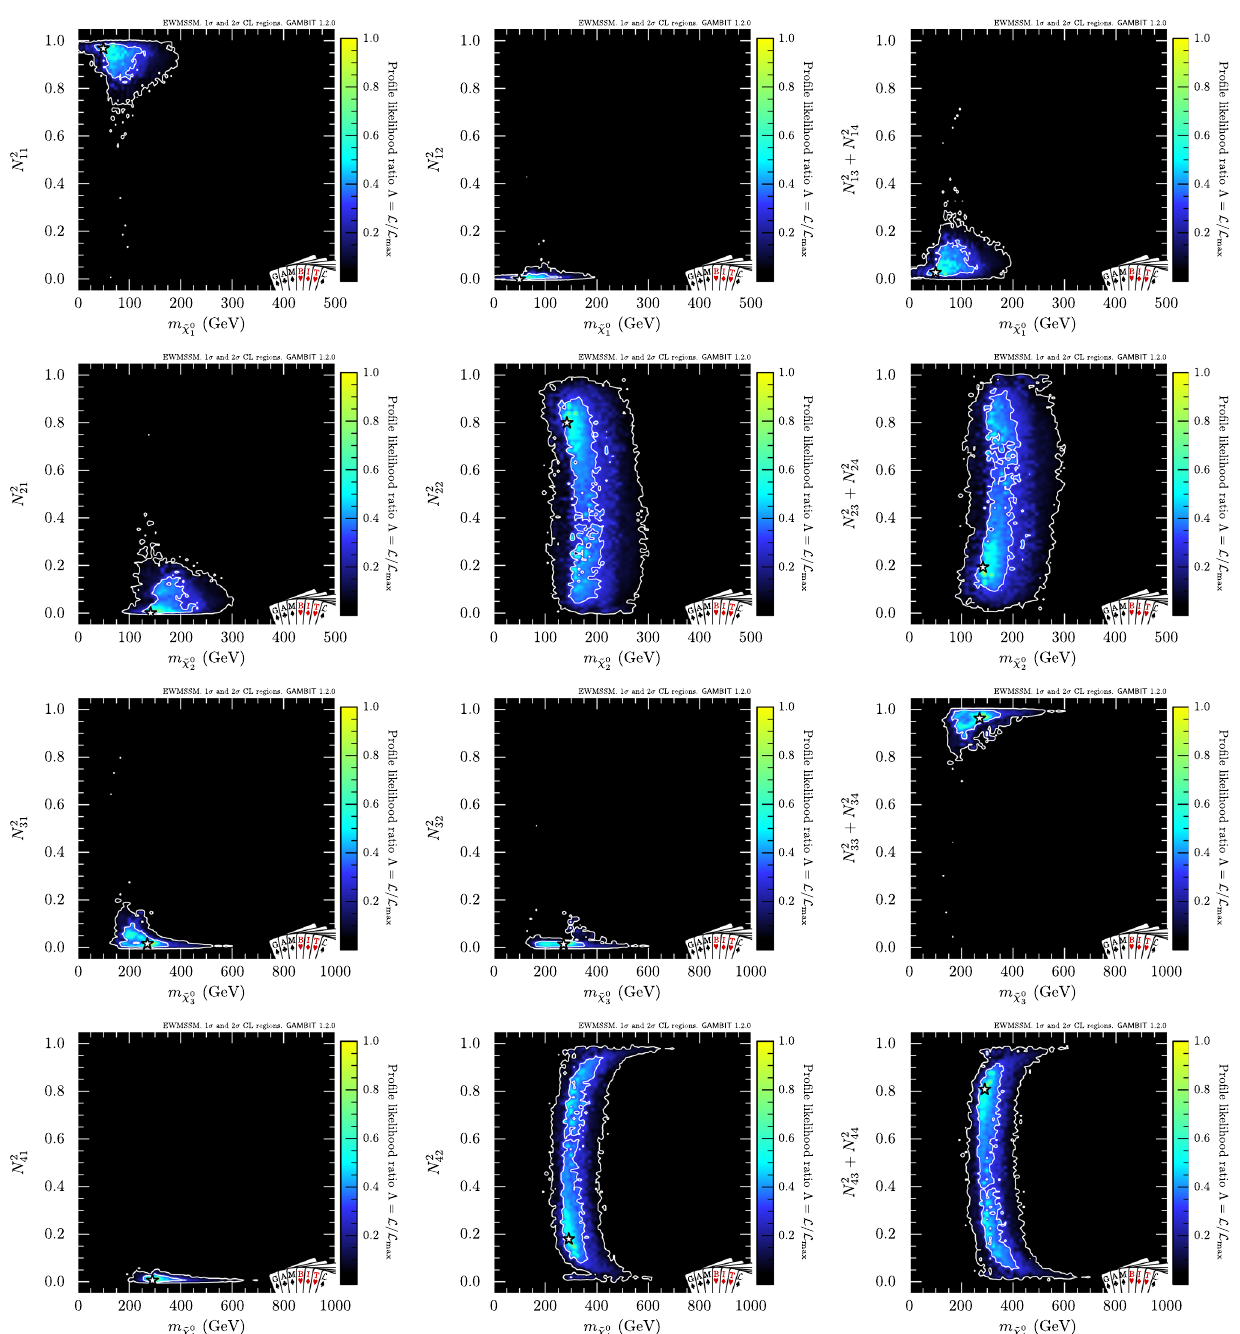
Fig. 7 Profile likelihood of the bino (left), wino (middle) and Higgsino (right) content of the four neutralinos (starting from the lightest in the top row), plotted against the mass of the respective neutralino. Contour lines show the 1 σ and 2 σ confidence regions. The best-fit point is marked by the white